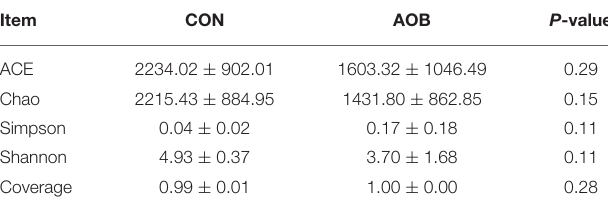
TABLE 3 | Alpha diversity indices of milk